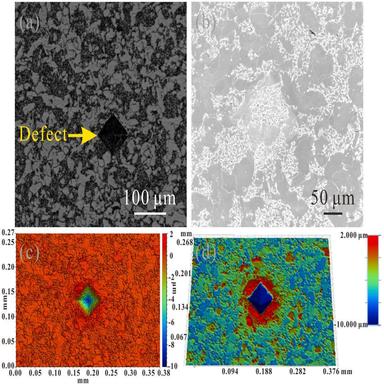
The original position HTC method for defects in TC4 titanium alloy: (a) surface profile image of an indentation defect presented by OM in 2D characterization methods; (b) surface profile SE image of an indentation defect presented by HTSEM in 2D characterization methods; (c) 2D contour map of surface profile presented by WLI in 3D characterization methods for an indentation defect, with corresponding 3D surface profile morphology as (d).